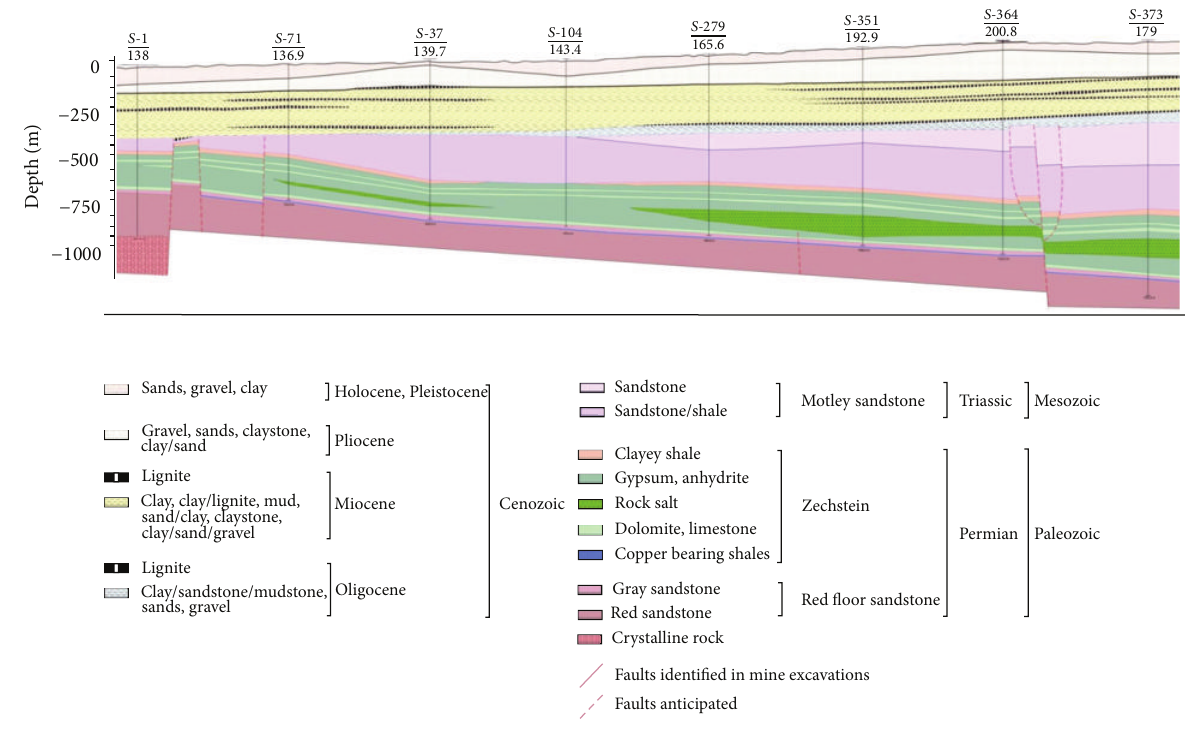
Figure 2: The cross-section of the southern part of the mining areas for the Legnica-Glogow Copper Area (LGOM) [13].